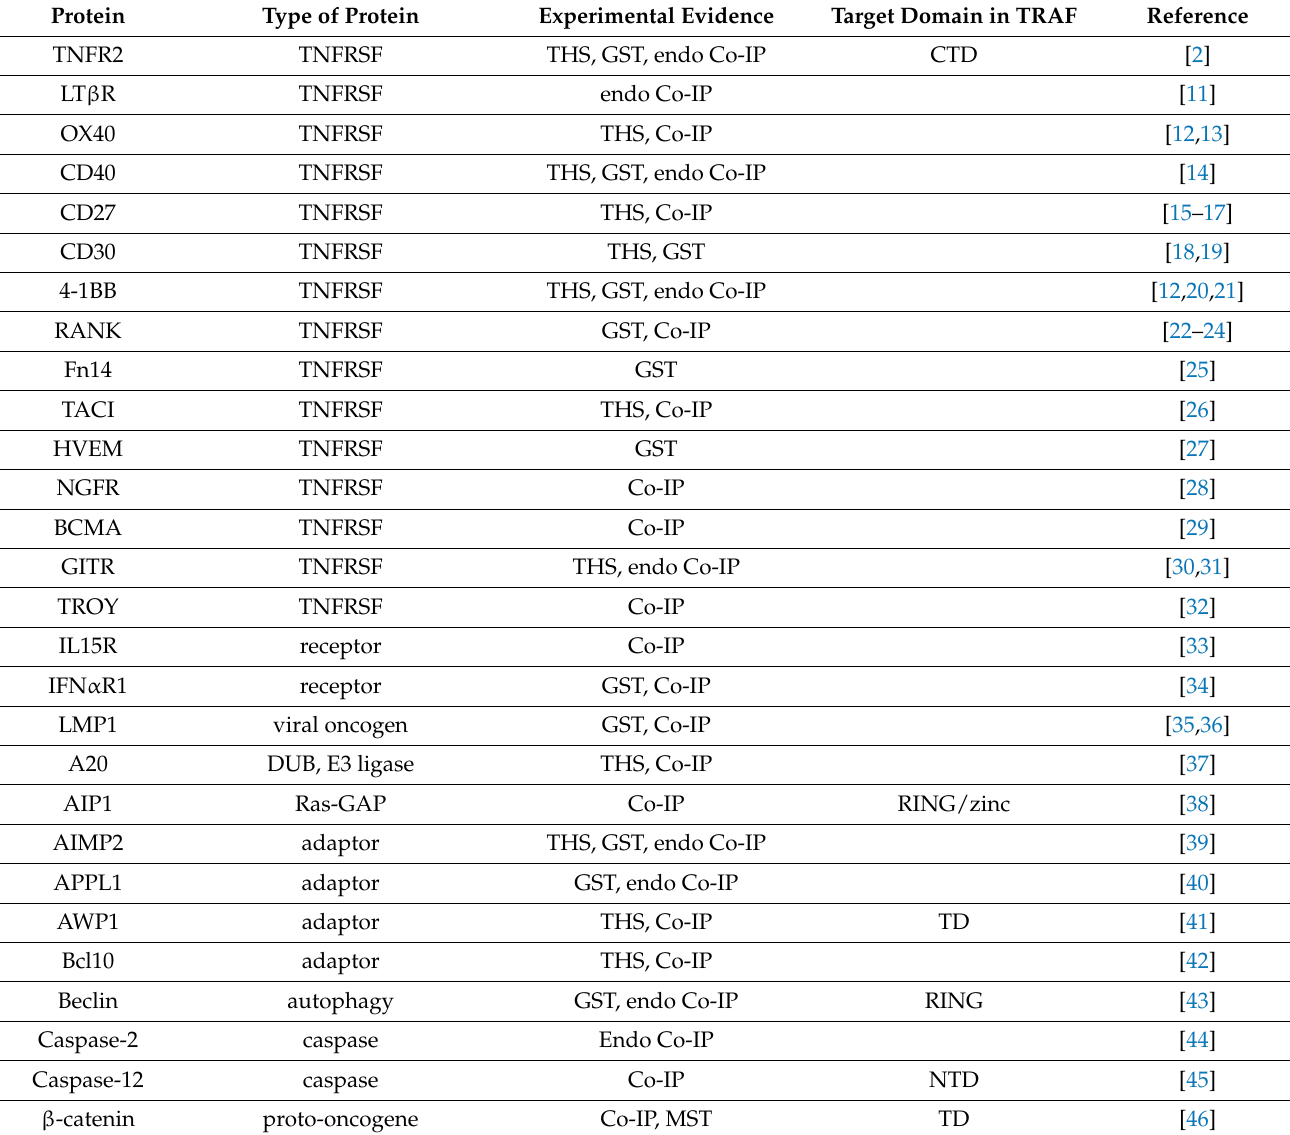
Table 1. TRAF2 interacting